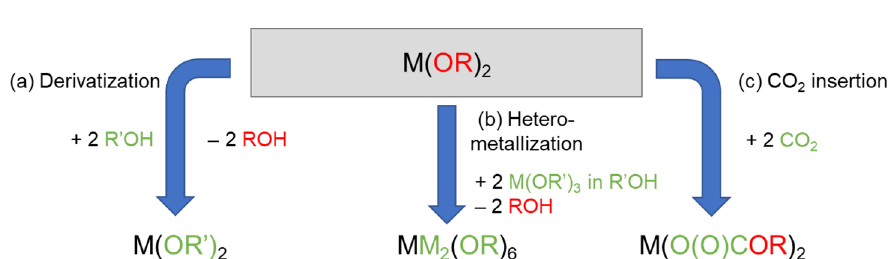
Figure 2. Solubilization strategies for metal alkoxides (R: alkyl